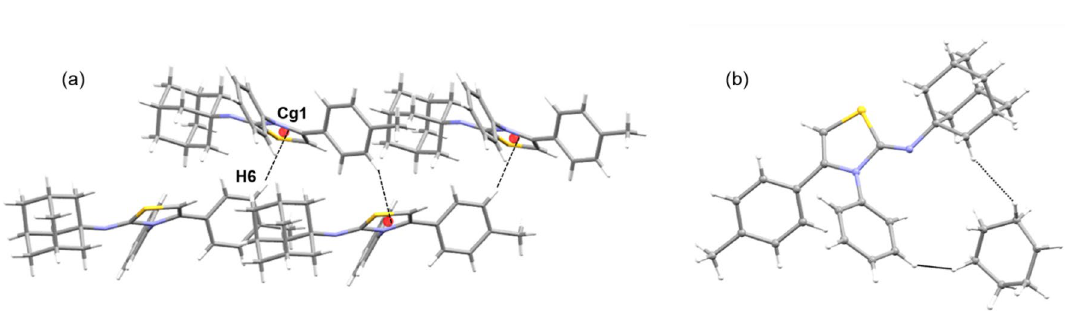
Figure 5. ( a ) Molecular chain formed by a weak C–H…π interaction in the solid state of compound and ( b ) cyclohexane…adamantane/phenyl interactions in compound 5d